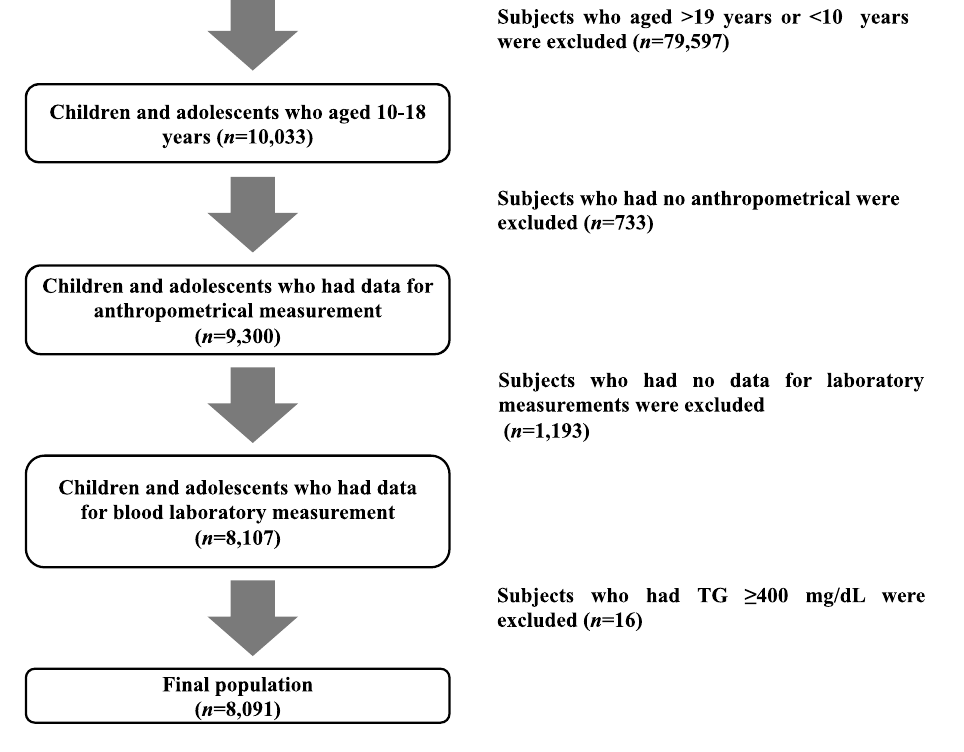
Figure 1. Flow chart of the study population ( n =